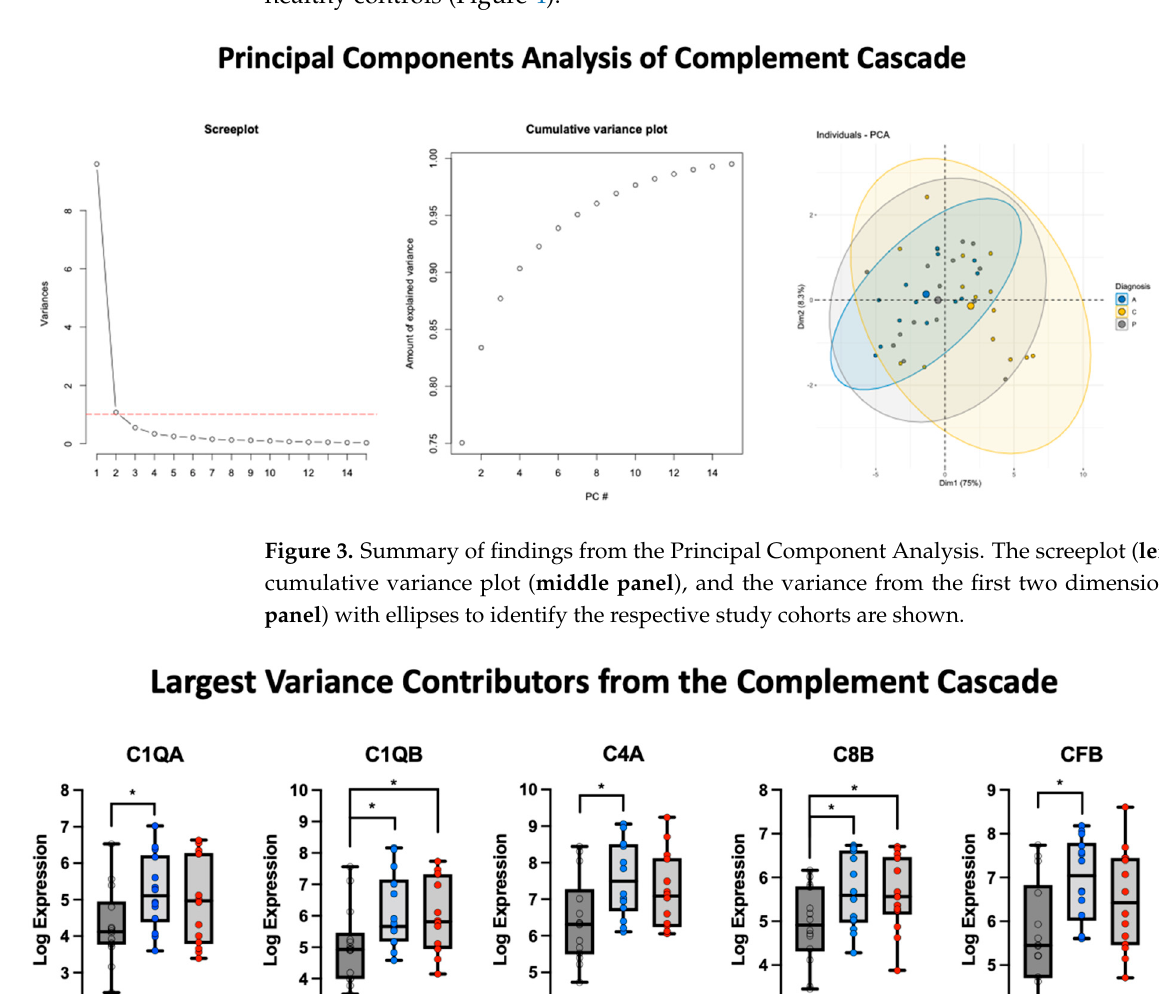
Figure 2. Initiation and Regulation of the complement cascade. Markers are presented for factors that were found for at least one cohort to be above detectable limits. Samples were found to be statistically significant (filled boxes or circles) if they had p -values < 0.05. Error bars represent one standard deviation.